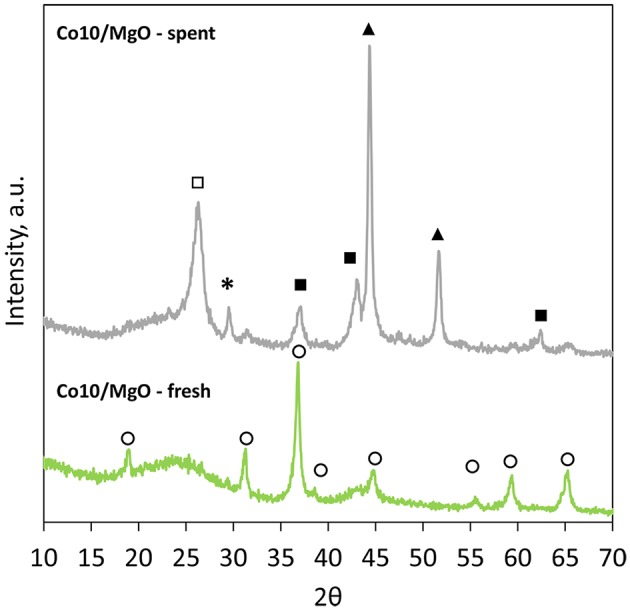
XRD patterns of fresh and spent Co10/MgO (*, CaCO3; ◦, Co3O4; ■, MgO; ▴, Co; □, graphite).